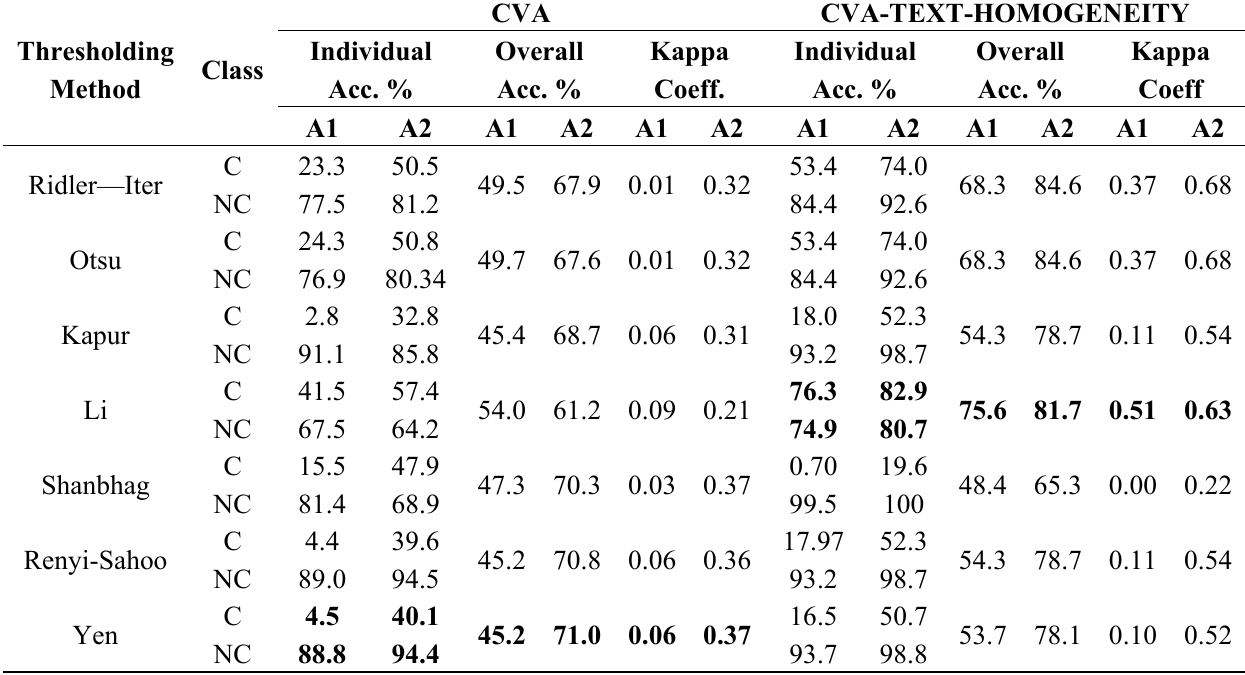
Table 3. Individual and global accuracies obtained for the thresholded indices corresponding to level 3, areas A1 &